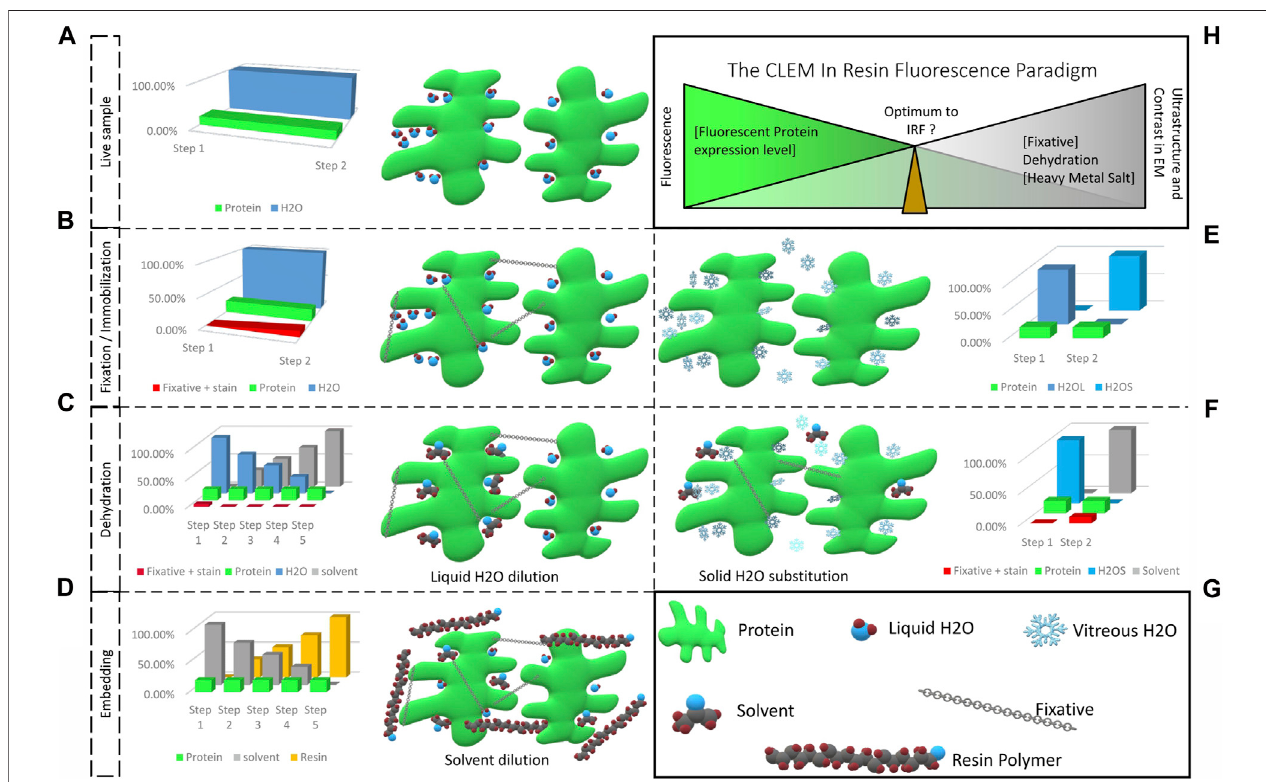
FIGURE 1 | From a living fl uorescent biological sample to an embedded specimen for light and electron microscopy, pitfalls and trade-offs. (A) Living matter is essentially composed of water and proteins, lipids and carbohydrates. Protein functions are related to their structural shape, supported by several scaffolding proteins. (B) During chemical fi xation the sample is immobilized by cross-linking. The fi xative, mostly aldehyde compounds, creates bonds between proteins, lipids and carbohydrates. Diffusion and fi xation ef fi ciency is affected by the sample ’ s density and the pH of local sub-compartments. (C) In the following dehydration in increasingconcentrationsofsolvent,unbound fi xativeisprogressivelyelutedtogetherwiththewaterboundinthesample. (D) Thesolventisthenprogressivelyreplaced by resin and polymerization is initiated (by heat or UV polymerization). Depending on the type of resin, chemical bonds can be formed between sample and resin, which providecomplementary fi xation. (E) Physical fi xation,ontheotherhand,instantaneouslyandhomogeneouslyimmobilizestheentiresample,goingfromahydratedliving state (H 2 OL) to a cryo-immobilized state (H 2 OS) in a matter of milliseconds. Ice crystal growth resulting in damage of the ultrastructure is prevented and the water moleculesremaininplace. (F) Thevitri fi edspecimenisdehydratedinsolventat − 90 ° C.Thesolventsubstitutesthesolidwater,moleculebymolecule.Ifchemical fi xatives are added, these are simultaneously diffused into the specimen. These fi xatives become active only above − 60 ° C. (G) Graphical legend. (H) The CLEM in-resin fl uorescence paradigm. Moving from the living, fl uorescent sample to the ideal fi xed electron microscopy material inevitably causes fl uorescent protein quenching. The ideal IRF protocol is a compromise between acceptable fl uorescence loss to identify the protein of interest after resin embedding, and adequate ultrastructure preservation and imaging contrast to achieve exploitable EM